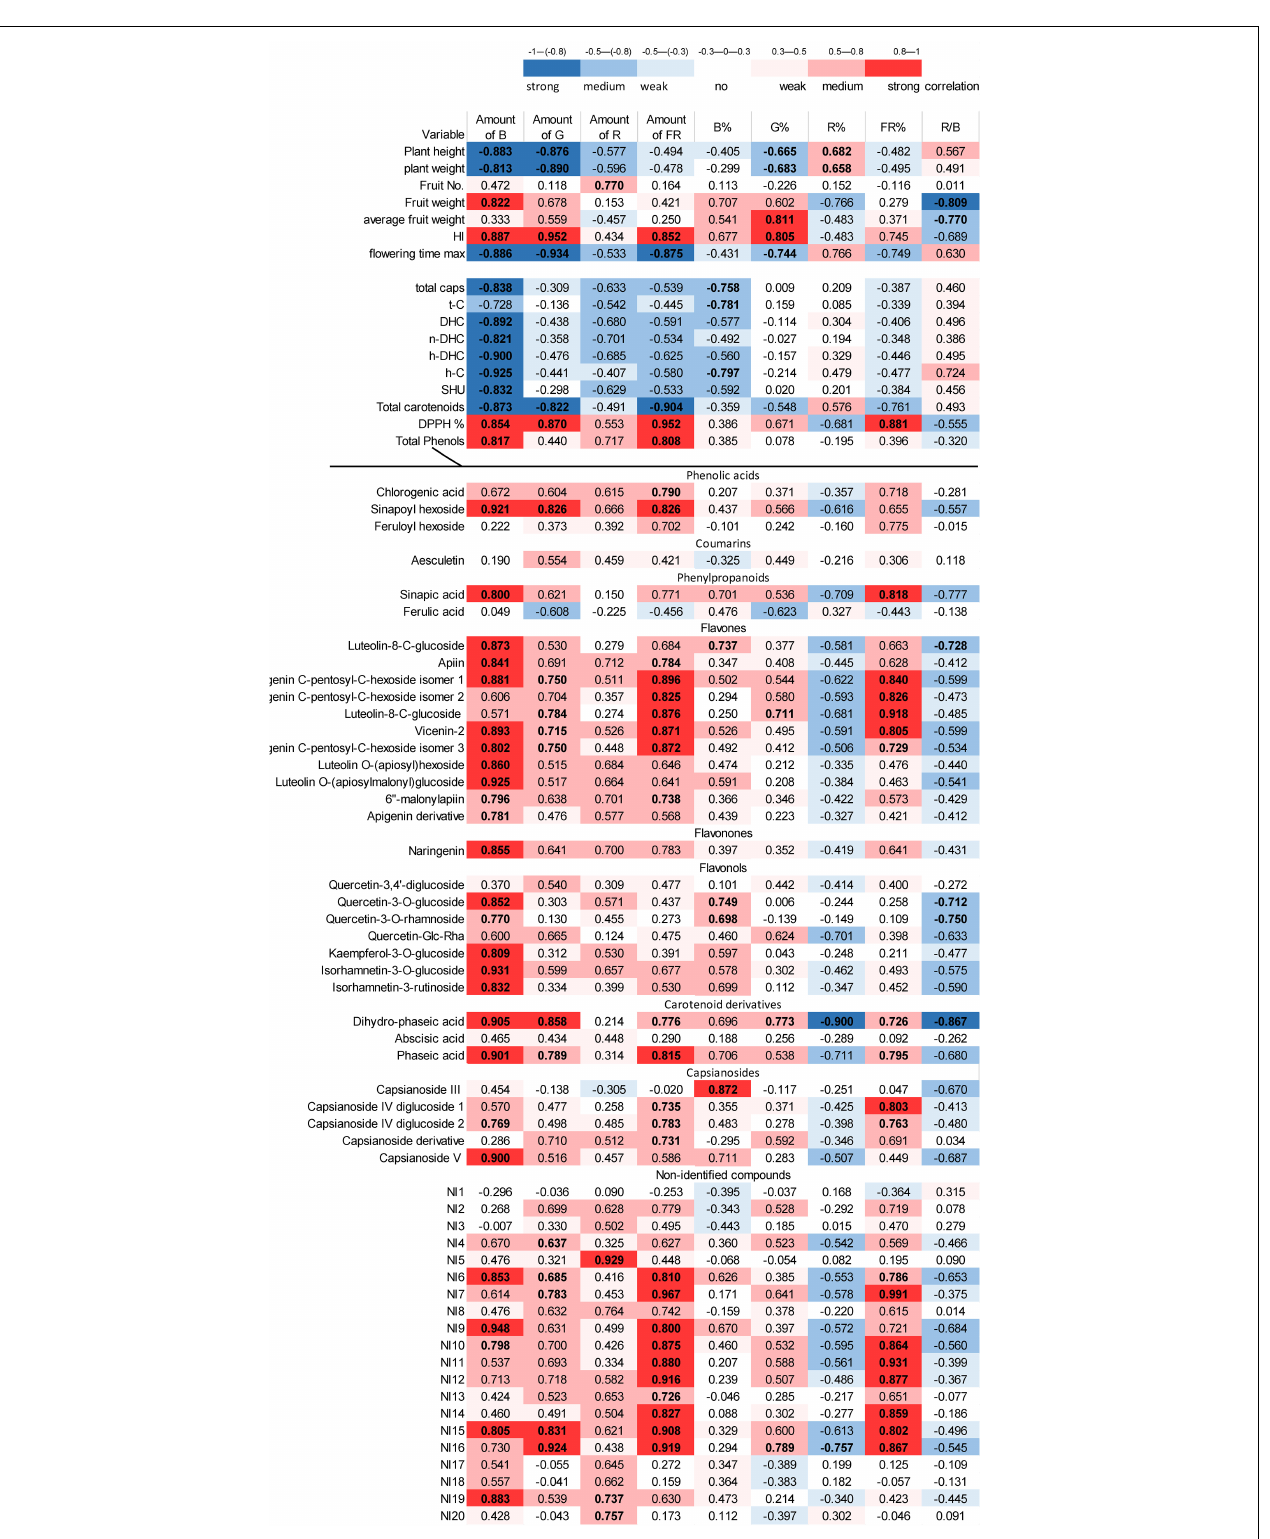
Frontiers in Plant Science |